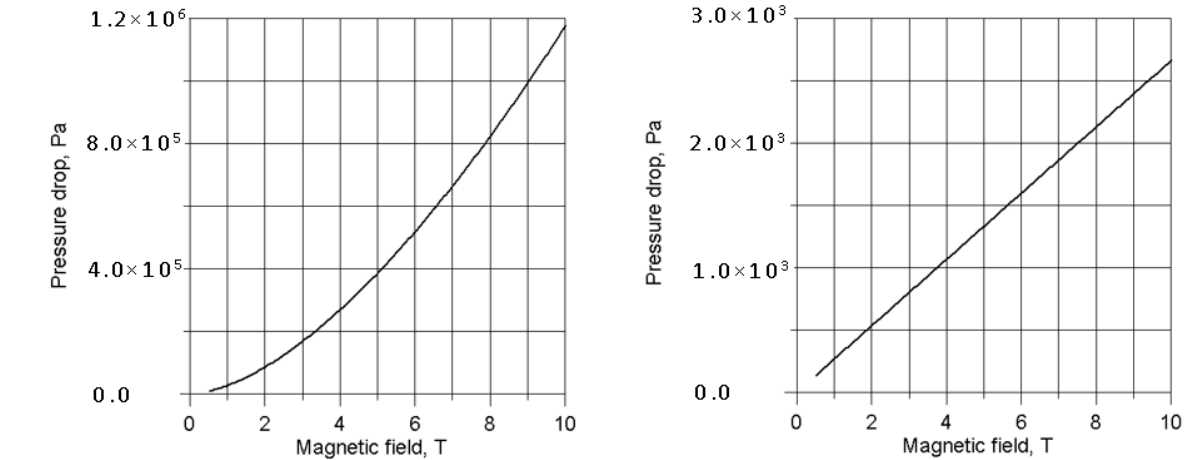
Figure 8. Effect of the magnetic field on the MHD pressure drop in the PbLi flow in a square duct at b = 0.1 m, l = 10 m, and U m = 0.1 m/s: ( a ) thin steel Hartmann walls with t w = 5 mm (Hunt solution 2), and ( b ) all walls are non-conducting (Shercliff flow).